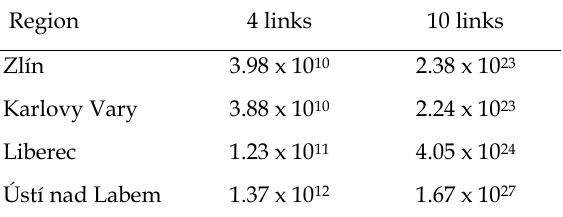
Table 2. The numbers of all the combinations of links. Region 4 links